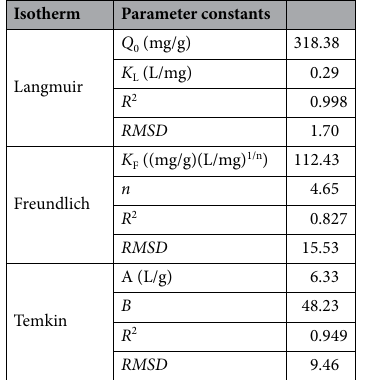
Table 1. Adsorption isotherm parameters for the adsorption of MB onto BB at 30 °C.